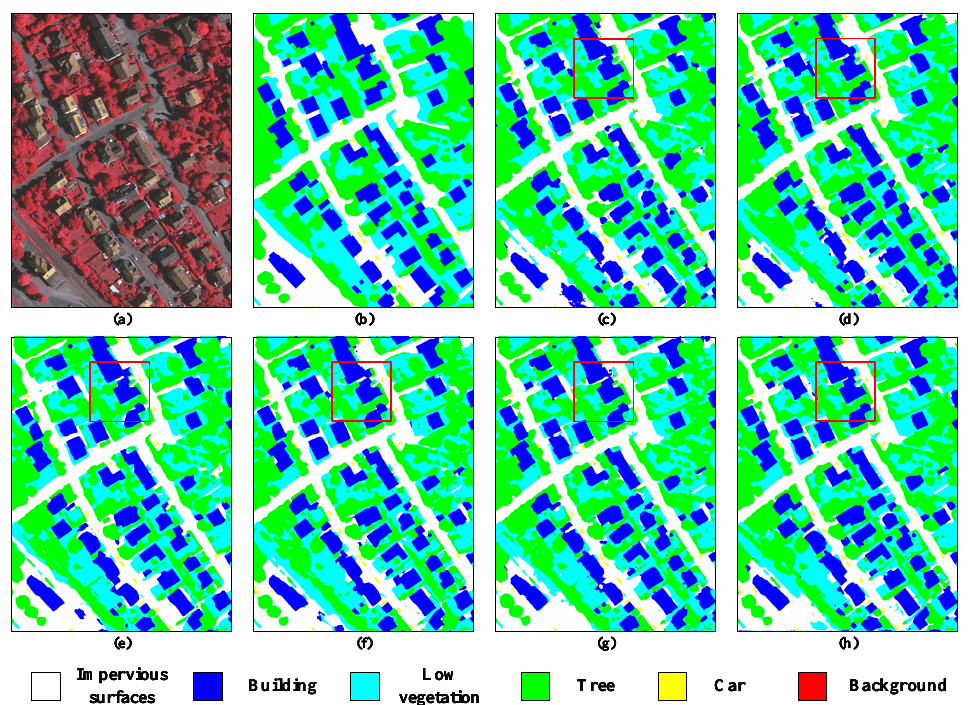
Figure 11. Examples of segmentation results derived from the Vaihingen dataset with the whole image size setting. ( a ) IRRG image. ( b ) Ground truth. ( c ) FPENet. ( d ) ERFNet. ( e ) DDRNet23-slim. ( f ) STDC1. ( g ) BiSeNet V1. ( h ) BiSeNet V2. ( i )